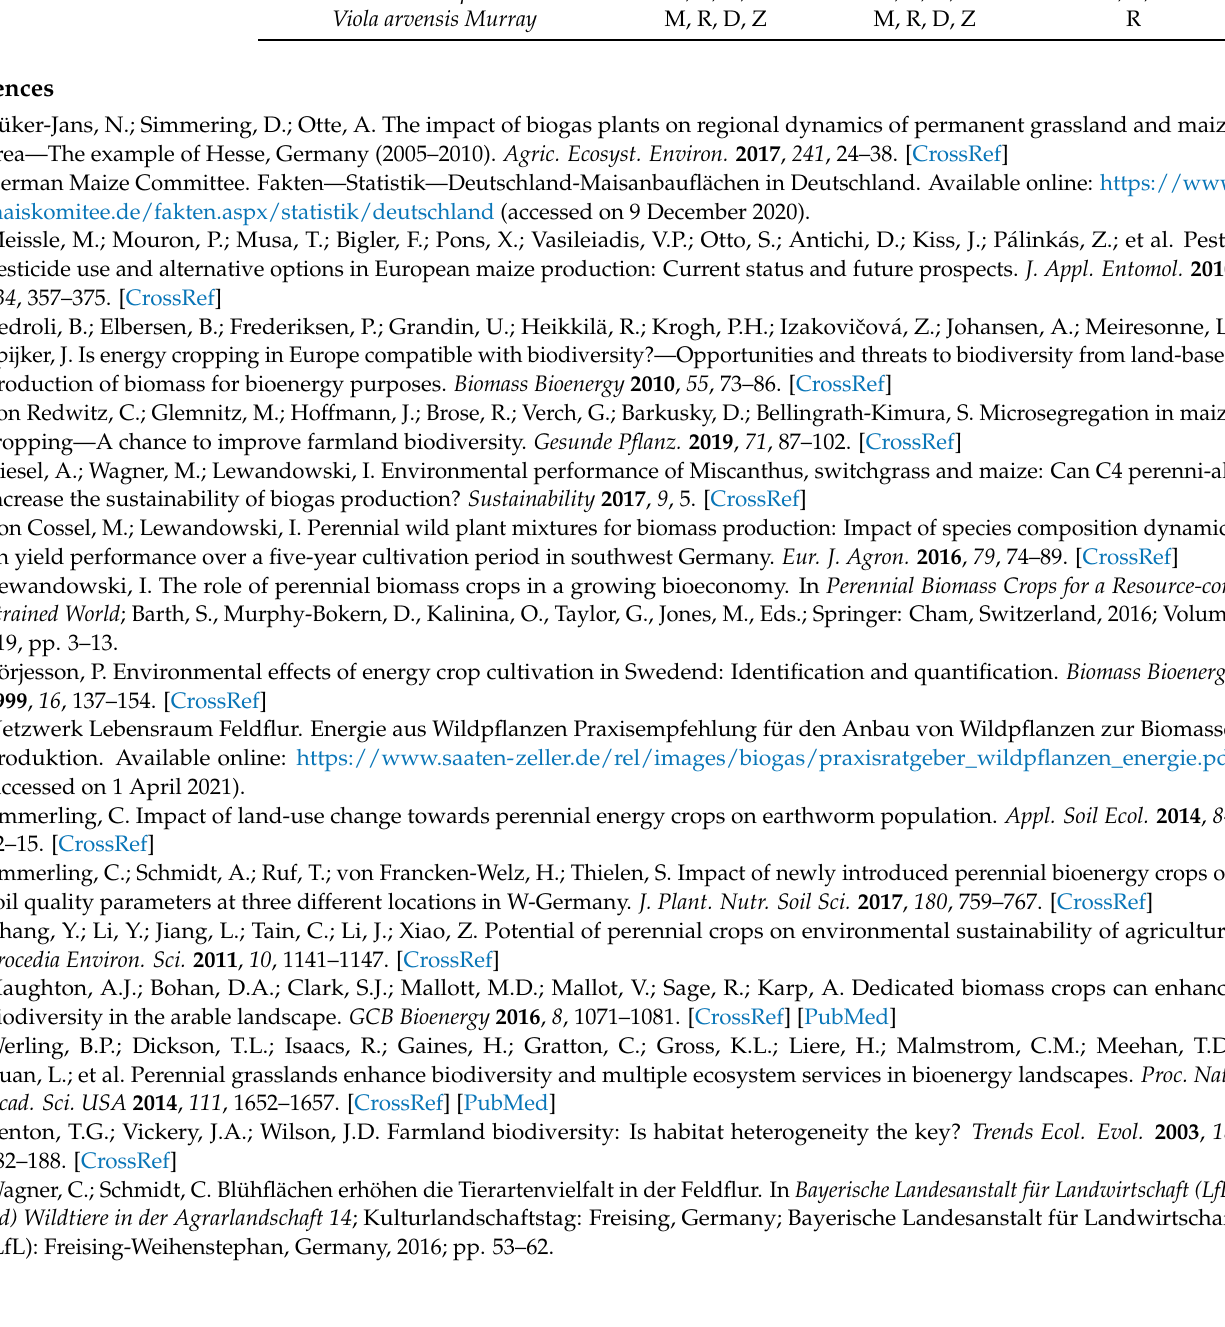
Table A1. Cont. Weed Species Spergula arvensis L. Stellaria media Vill . Taraxacum officinale F. H. Wigg